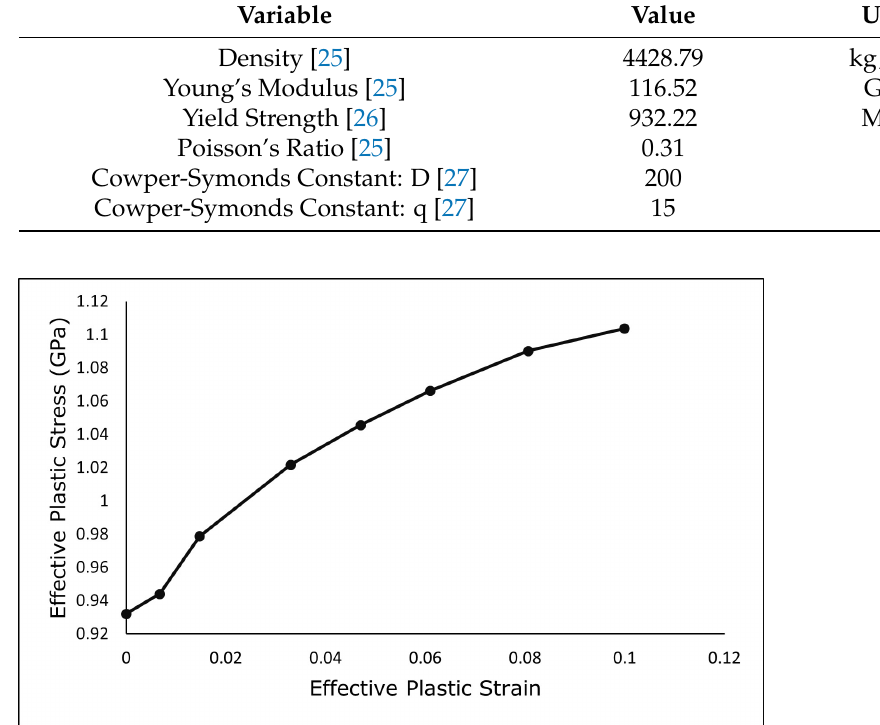
Figure 6. Ti-6Al-4V Effective Plastic True Stress-Strain Curve